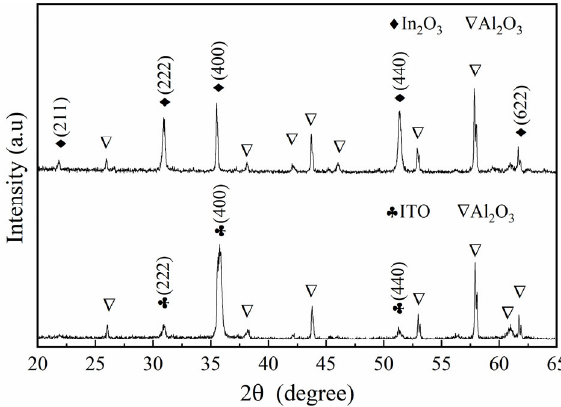
Figure 4. XRD patterns of ITO and In 2 O 3 thin films. Figure 4. XRD pa tt erns of ITO and In 2 O 3 thin fi lms. Figure 4. XRD pa tt erns of ITO and In 2 O 3 thin fi lms.